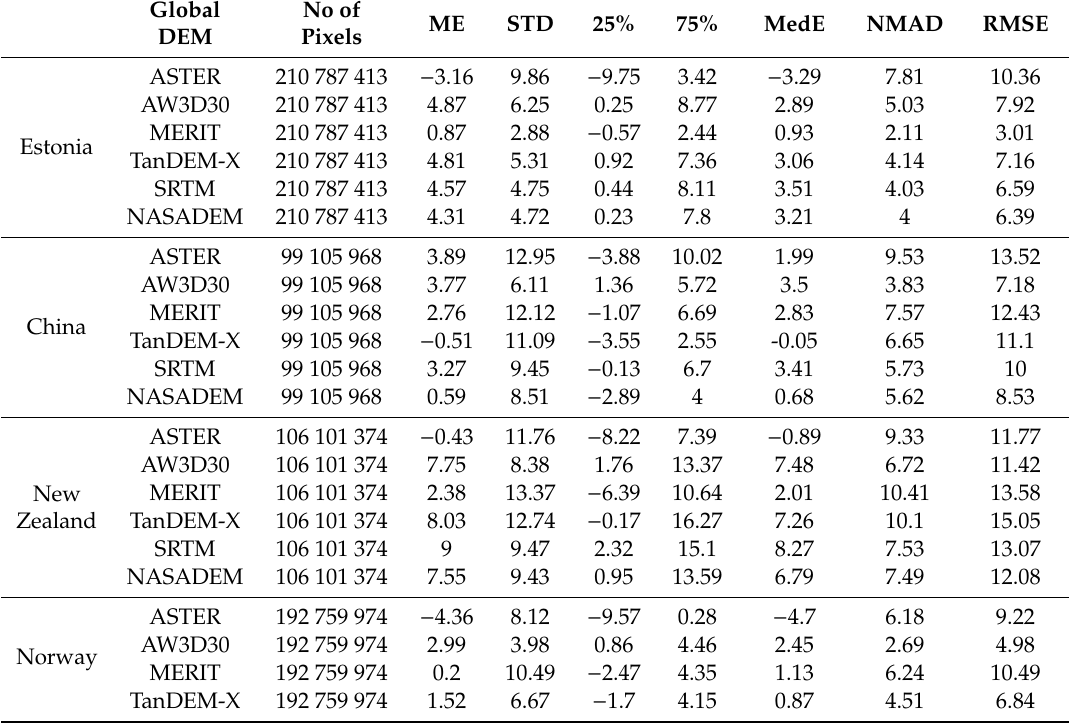
Table 3. Error measures for the ASTER, AW3D30, MERIT, TanDEM-X, SRTM, and NASADEM digital elevation models for the four study areas. SRTM and NASADEM data were not available for the Norwegian study area because of its high latitude. Error terms: ME, mean error; STD, standard deviation; 25% and 75%, quantiles; MedE, median error; NMAD, normalized median absolute deviation; RMSE, root-mean-square